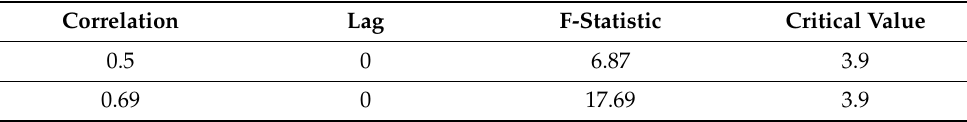
Table 2. Statistics of west Himalaya Mode 1 vs. climatic